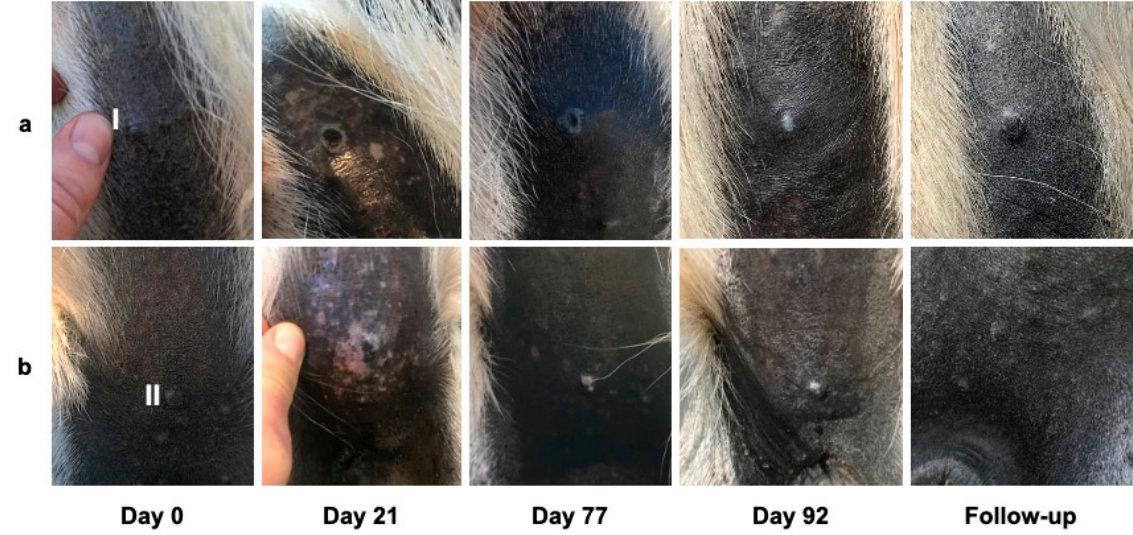
Figure 5. Clinical changes in melanoma I and II in horse 18 over time. The clinical changes in melanoma I ( a ) and melanoma II ( b ) on days 0, 21, 77 and 92 of the study and at follow-up examination. The tumors were treated twice a day with the placebo preparation (“Basiscreme DAC” + 20% medium-chain triglycerides). A crust formed on melanoma I on the 13 th day of treatment. When the crust was removed on day 19, the skin was ulcerated and the tissue underneath the crust was black and surrounded by an epithelial border. The tumor had decreased noticeably in size. The area was completely